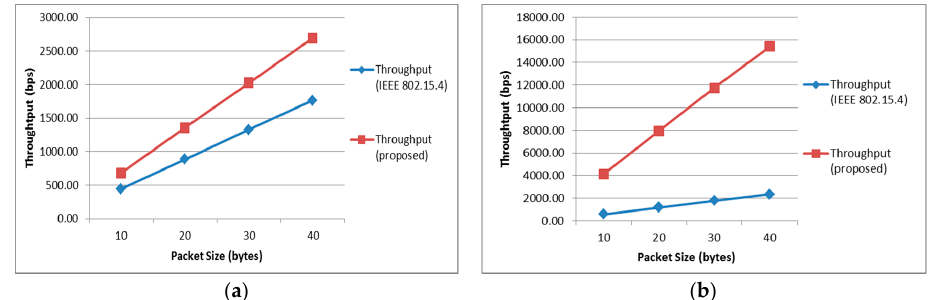
Figure 5. Maximum achievable throughput showing the best and worst cases of the proposed and conventional schemes according to the packet size: ( a ) Best Case; ( b ) Worst Case.